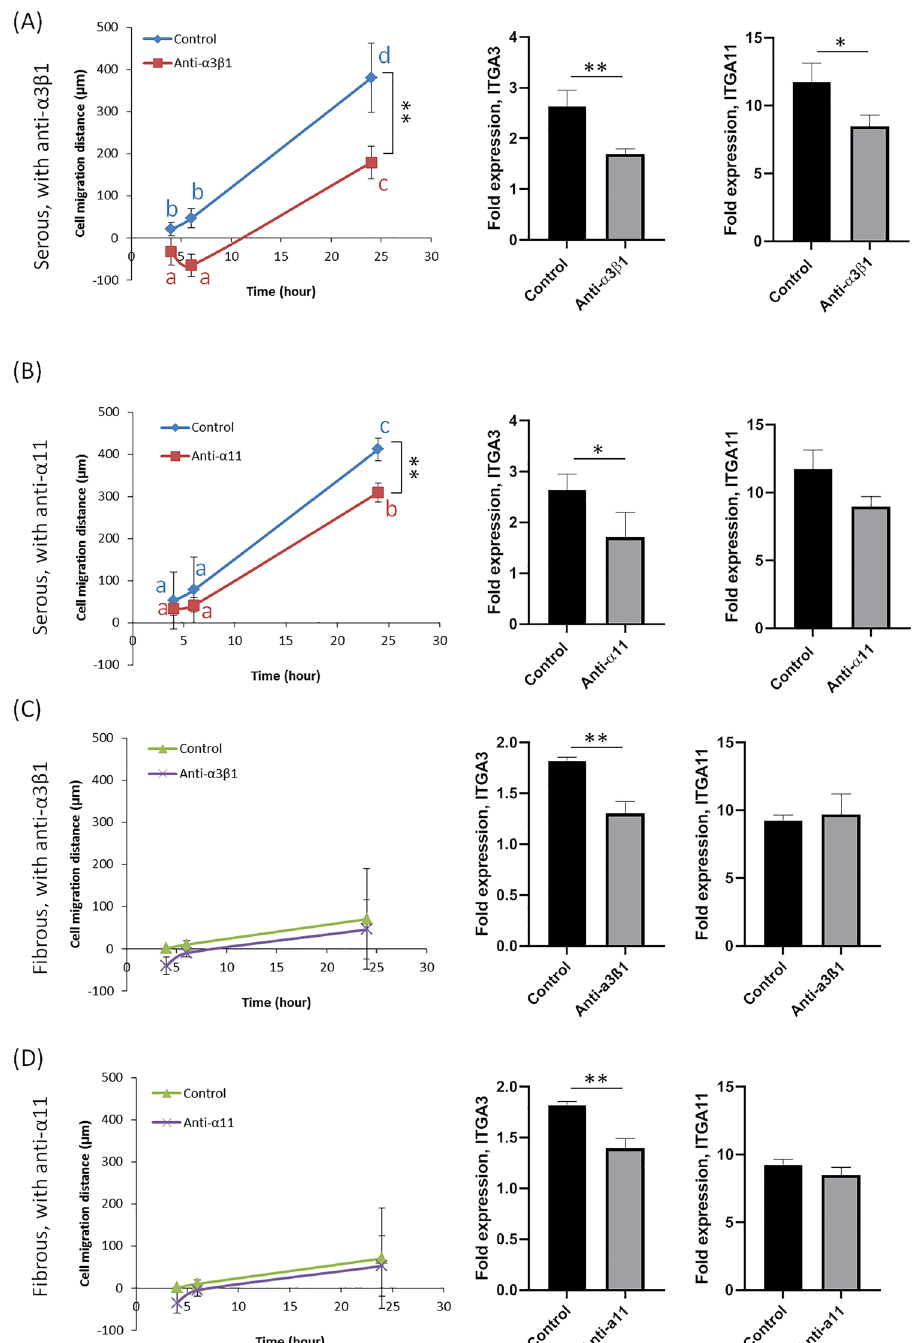
Figure 6. Effect of integrin blocking antibodies on cell migration and gene expression. Anti-α 3 β 1 represents culture with integrin α 3 β 1 antibody added; anti-α 11 represents culture with integrin α 11 antibody added; control represents culture without any antibody addition. ( A ) Addition of anti-integrin α 3 β 1 (20 µg/mL) on serous side cell culture, significantly reduces cell migration. Additionally, expression of ITGA3 and ITGA11 are reduced following anti-integrin α 3 β 1 antibody blockade. ( B ) Addition of anti-integrin α 11 (20 µg/mL) on serous-side cell culture, significantly reduces cell migration only at later time points (i.e., 24 h). Expression of ITGA3, is reduced following anti-integrin α 11 antibody blockade. ( C ) Addition of anti-integrin α 3 β 1 (20 µg/mL) on fibrous side cell culture results in no significant difference in cell migration. Expression of ITGA3 is reduced following anti- integrin α 3 β 1 antibody blockade. ( D ) Addition of anti-integrin α 11 (20 µg/mL) on fibrous-side cell culture results in no significant difference in cell migration. However, expression of ITGA3 is reduced following anti-integrin α 11 antibody blockade. Statistical analysis was performed using one-way ANOVA with repeated measures for time series data (n = 6 scaffolds per group; *p < 0.05; **p < 0.01). Data points that are not connected by the same lower case letter are significantly